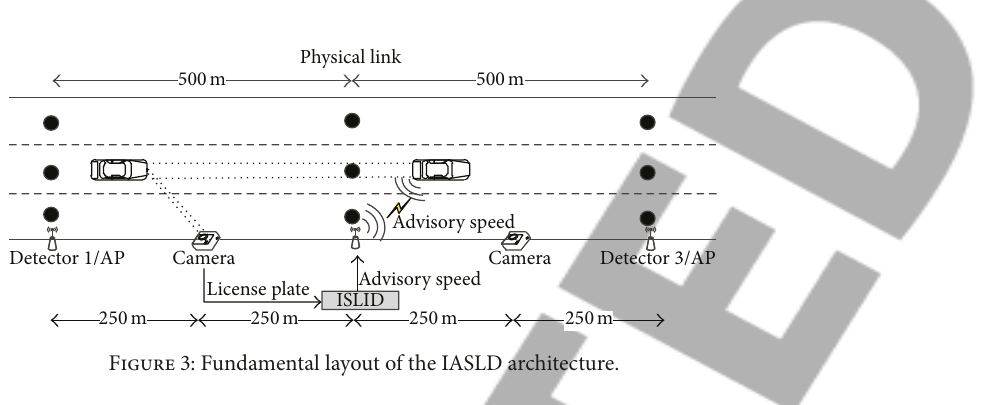
Figure 3: Fundamental layout of the IASLD